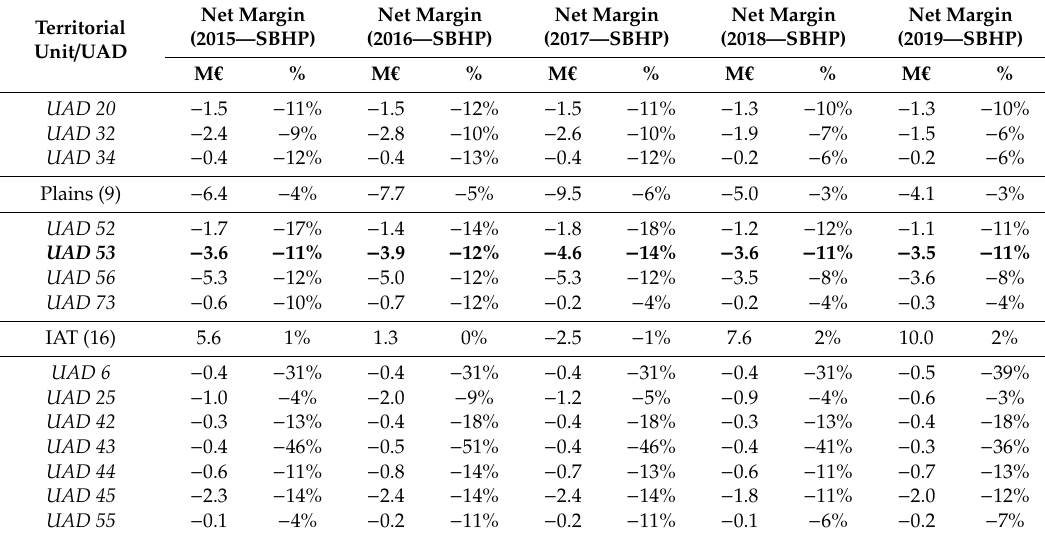
Table 16. Variation in the net margin in the years analysed with respect to the value obtained with the average water applied in the SBHP, examples of some UADs with a reduction in the period analysed. Source: SBHP. Own